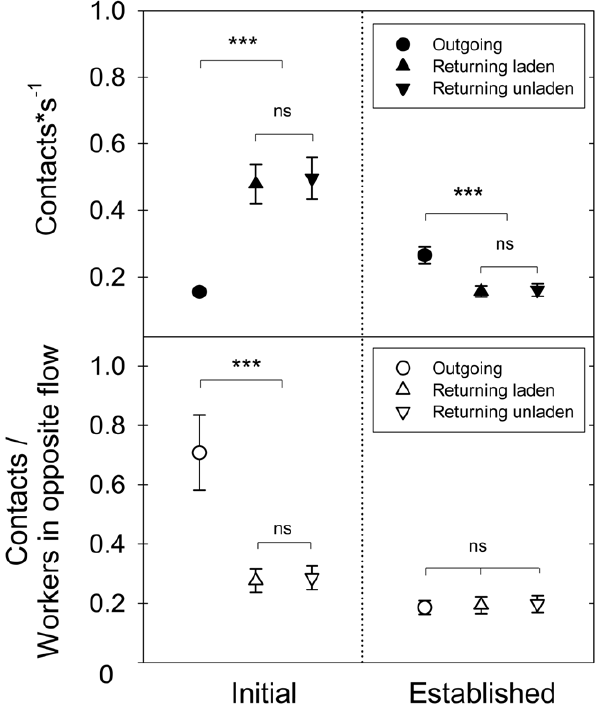
Figure 2. Interactions between outgoing and returning work- ers on the foraging trail. Top ) Rate of head-on-contacts (mean 6 SD) with workers coming from the opposite direction for single outgoing, returning laden and unladen workers during both the initial and established foraging phases (Initial: F 2,33 =28.03, p , 0.001; Established: F 2,33 =8.23, p , 0.01; asterisks indicate a difference at p , 0.01 after a Tukey post-hoc test, Log 10 transformed data). Bottom ) Number of head-on-contacts divided by the number of workers in the opposite flow, for both foraging phases (Initial: F 2,33 =9.82, p , 0.001; Established: F 2,33 =0.009, p=0.91, NS; asterisks indicate a difference at p , 0.01 after a Tukey post-hoc test, Log 10 transformed data).